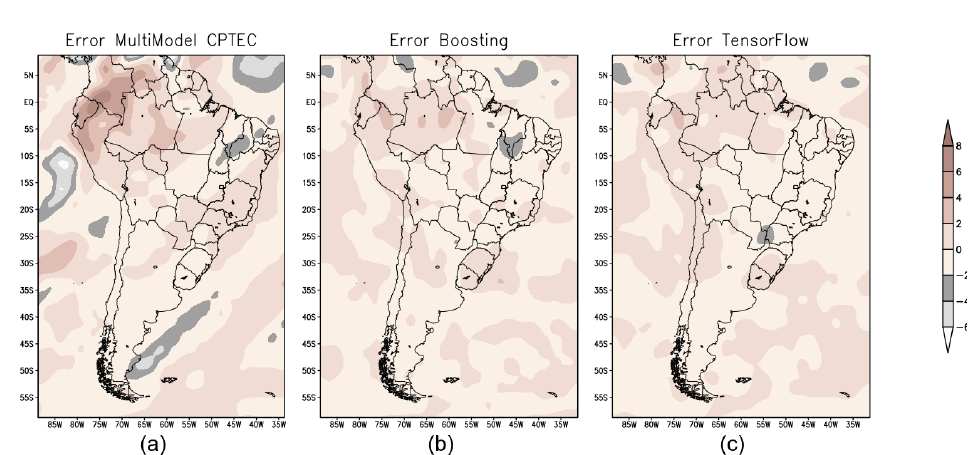
Figure 13. Error map for spring in South America to evaluate the performance of the forecast models: ( a ) error map produced from the difference between the GPCP precipitation dataset and the precipitation prediction by BAM; ( b ) error map for XGB; and ( c ) error map for TF.